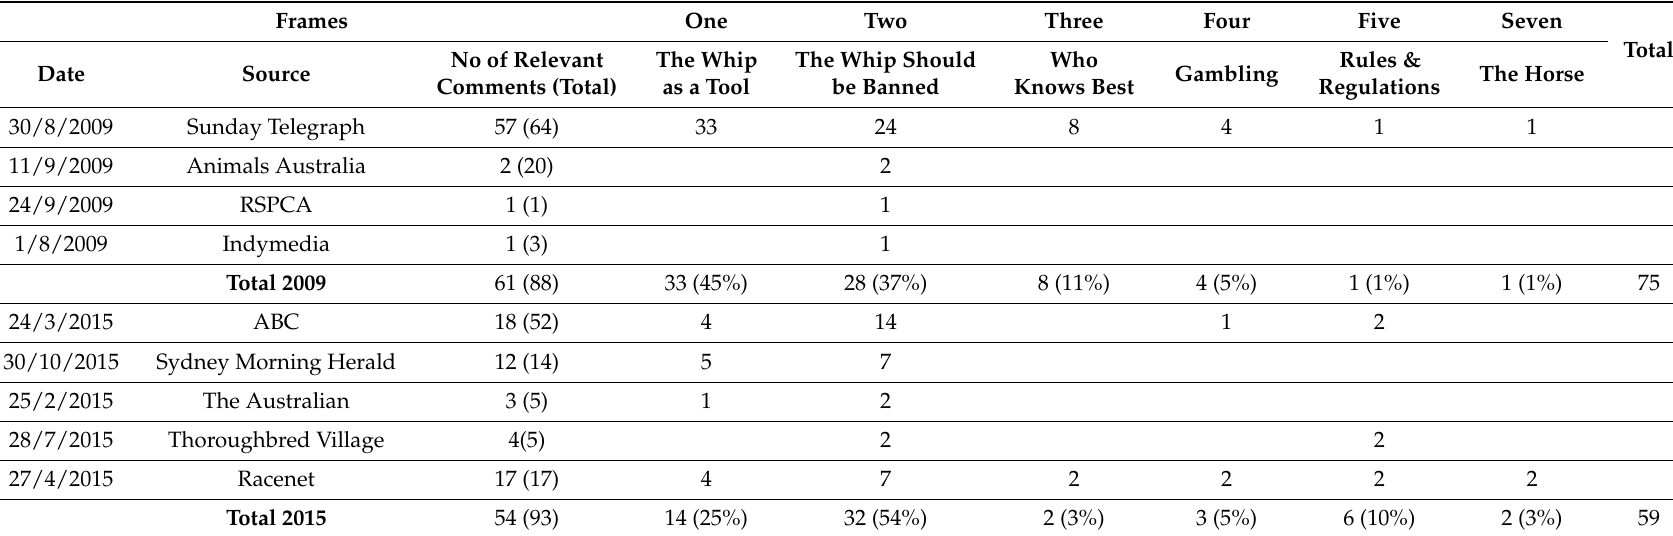
Table 6. Australia online readers’ comments 2009 and August